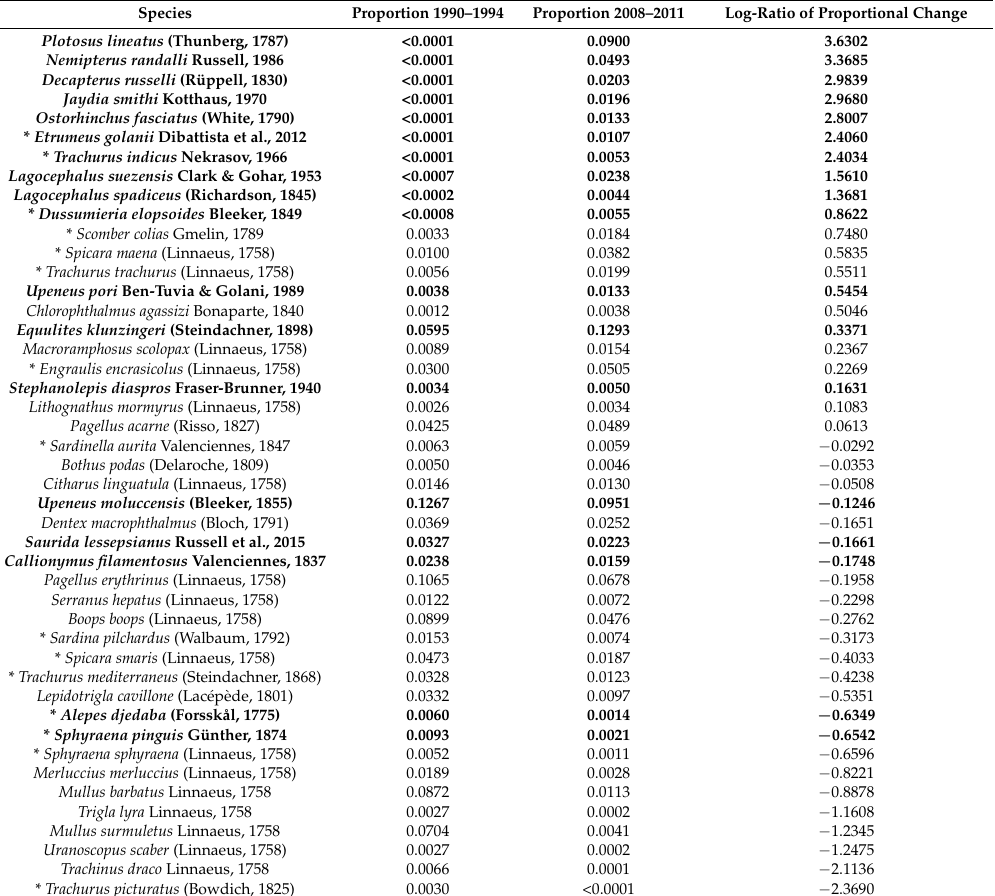
Table 1. Recorded fish species with proportions of ≥ 0.0025 during at least one of the trawl periods. Species are listed from largest relative increase to the largest decline of trawl proportions between 1990–1994 and